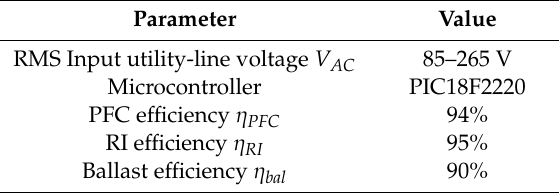
Table 4. E ffi ciency and ballast parameters.